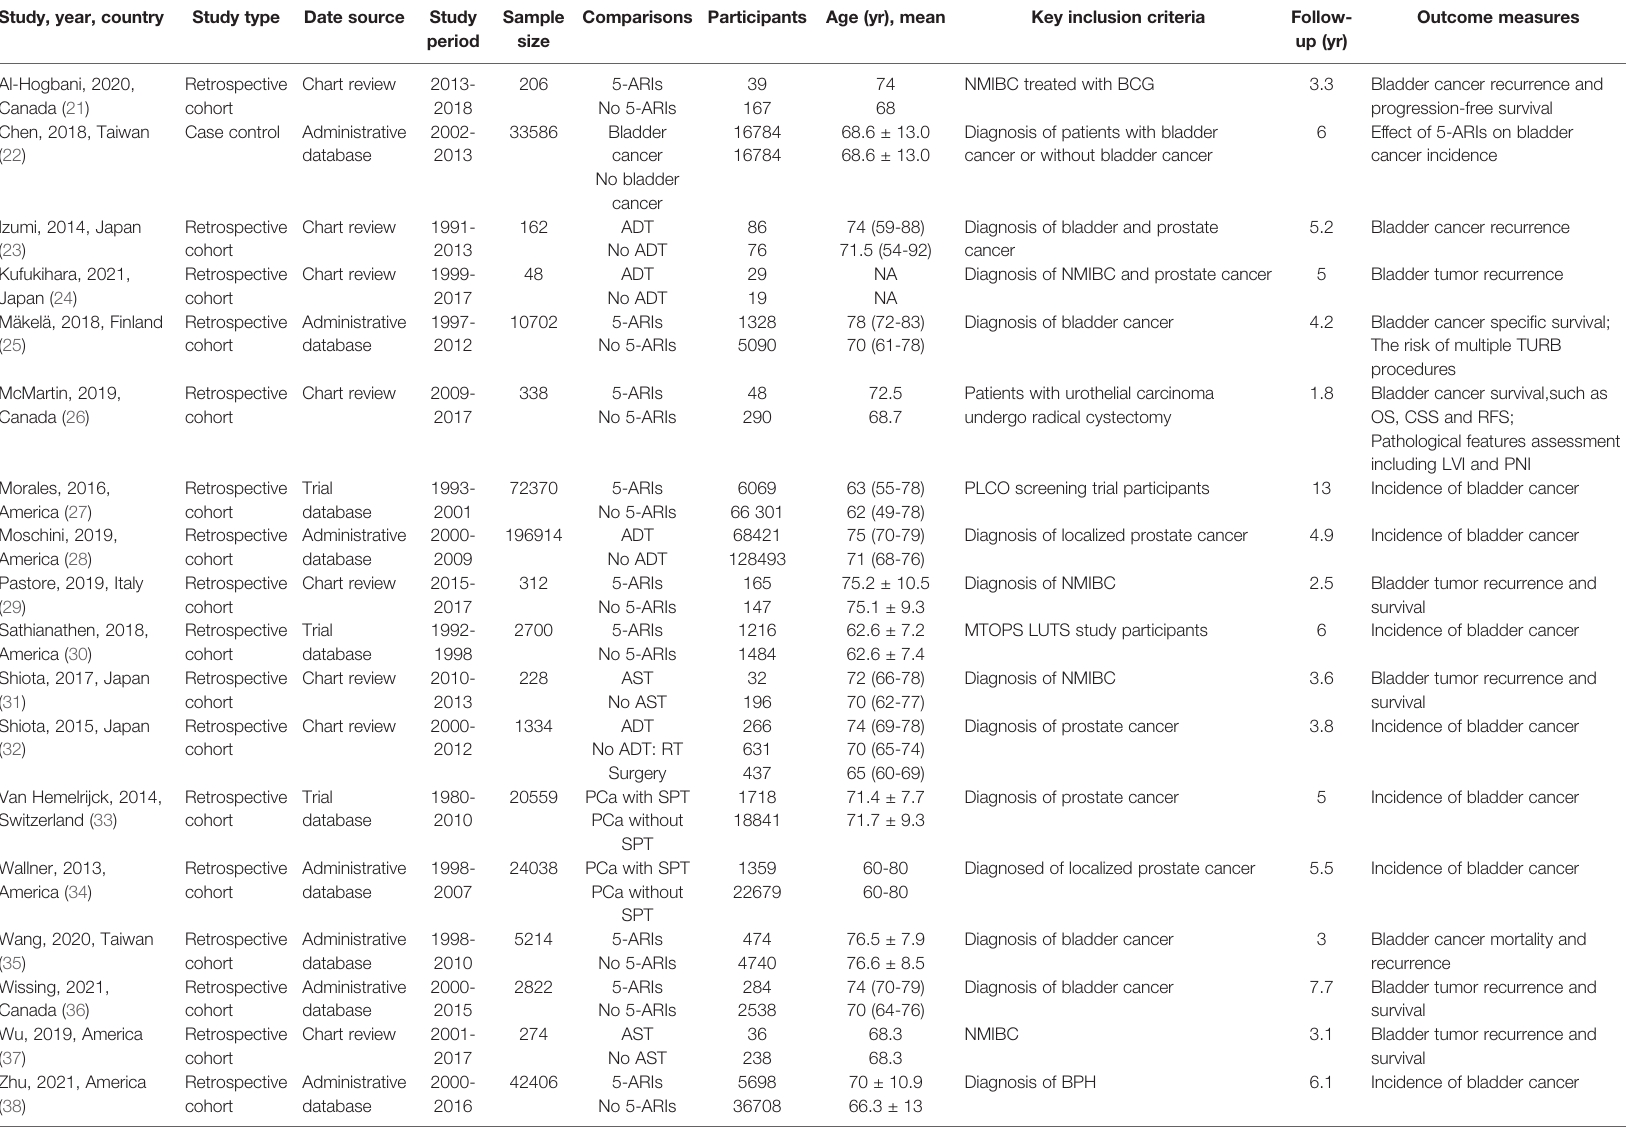
5-ARIs, 5-alpha reductase inhibitors; AST, Androgen suppression therapy; ADT, Androgen deprivation therapy; NMIBC, Non-muscle-invasive bladder cancer; BCG, Bacille Calmette-Guerin; NA, Not available; LUTS, Lower urinary tract symptoms; TURB, Transurethral resection of bladder; OS, Overall survival; RFS, Recurrence-free survival; CSS, Cancer-speci fi c survival; LVI, Lymphovascular invasion; PNI, Perineural invasion; MTOPS, Medical Treatment of Prostate Symptoms; RT, Radiotherapy; SPT, Second primary tumor; BPH, Benign prostatic hyperplasia; PLCO, Prostate, Lung, Colon,